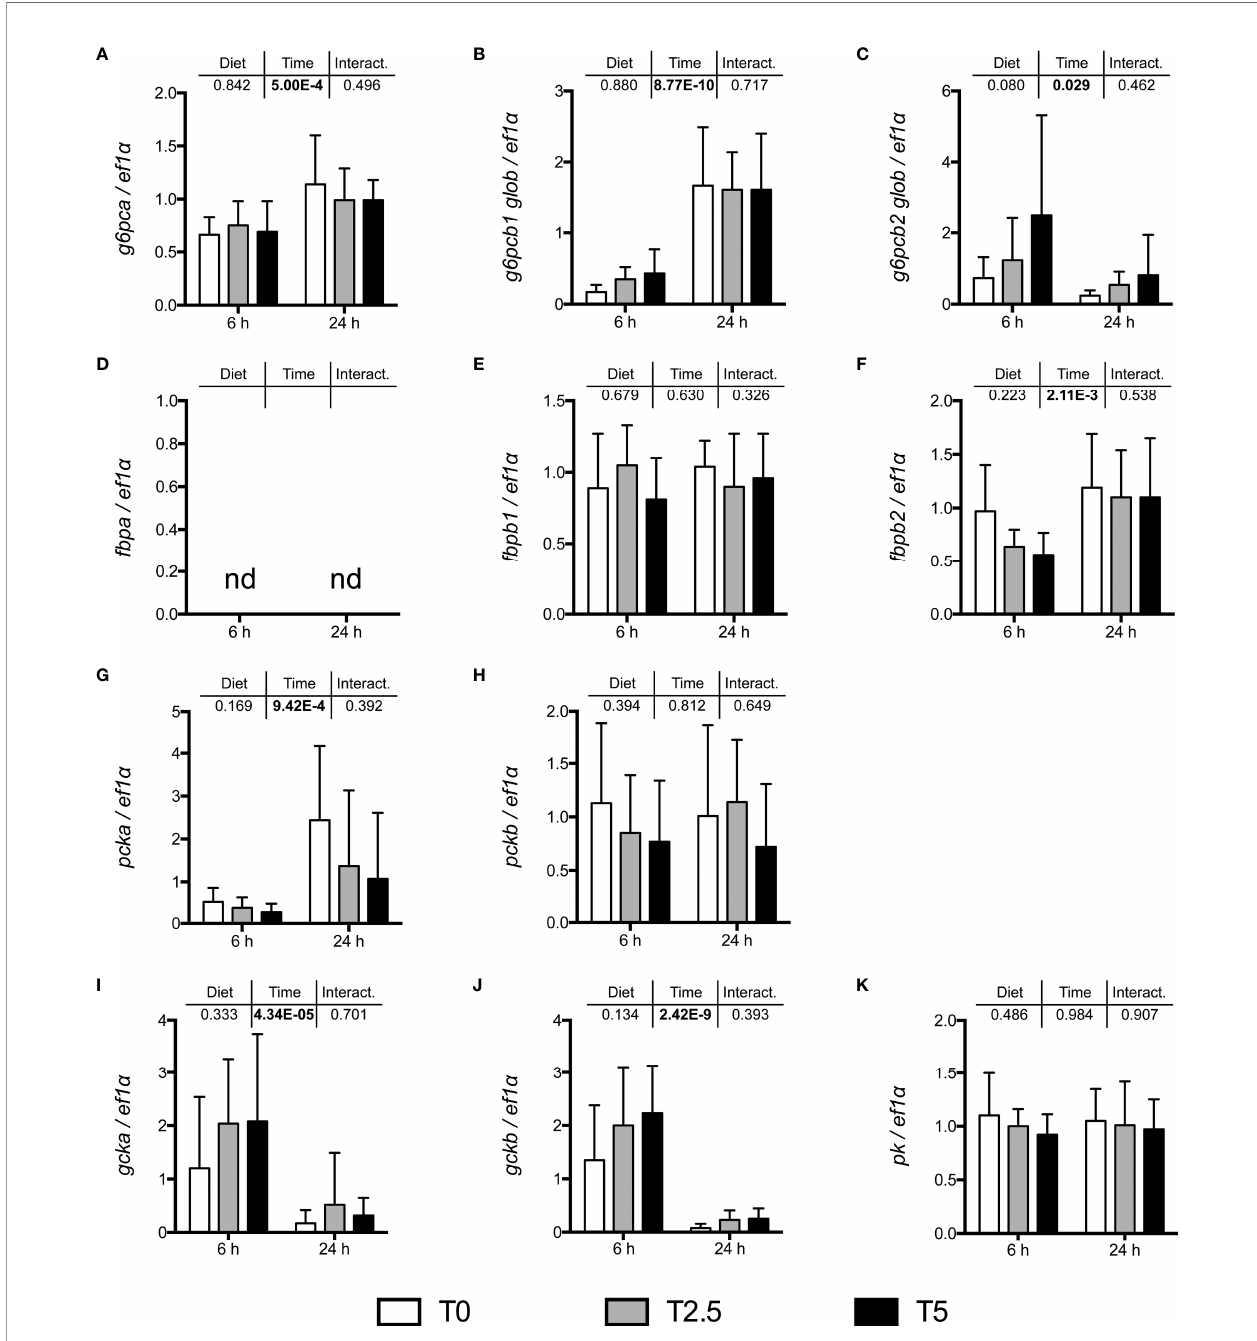
FIGURE 2 | mRNA levels of selected gluconeogenic enzymes (A) g6pca , (B) g6pcb1 , (C) g6pcb2 (glucose-6-phosphatase paralogs), (D) fbpa , (E) fbpb1 , (F) fbpb2 (fructose-1,6-bisphosphatase paralogs), (G) pcka , (H) pckb (phosphoenolpyruvate carboxykinase paralogs); and glycolytic enzymes (I) gcka , (J) gckb (glucokinase paralogs) and (K) pk (pyruvate kinase), in the liver of rainbow trout ( Oncorhynchus mykiss ) fed with different levels of glycerol (0, 2.5, and 5%) for 8 weeks. Values are mean ± SD (n = 8); nd, not detected. Signi fi cant differences were evaluated by two-way ANOVA (p < 0.05, values in